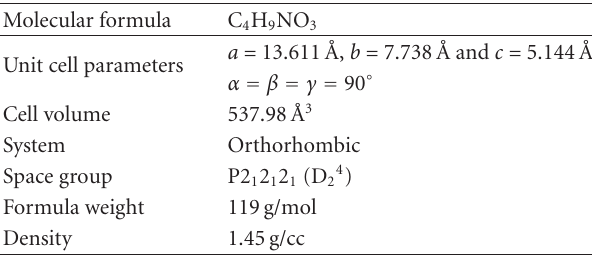
Figure 15: Molecular arrangement of L-threonine molecule. Table 2: Crystallographic details of L-threonine.